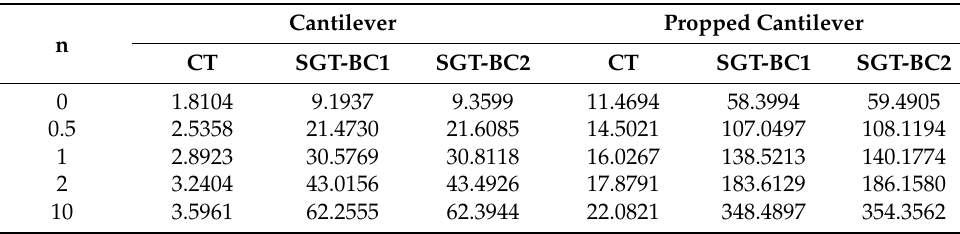
Table 5. Dimensionless buckling loads for nonhomogeneous tapered microbeams for various gradient indices ( α = 0.75, l L = h 1 ).